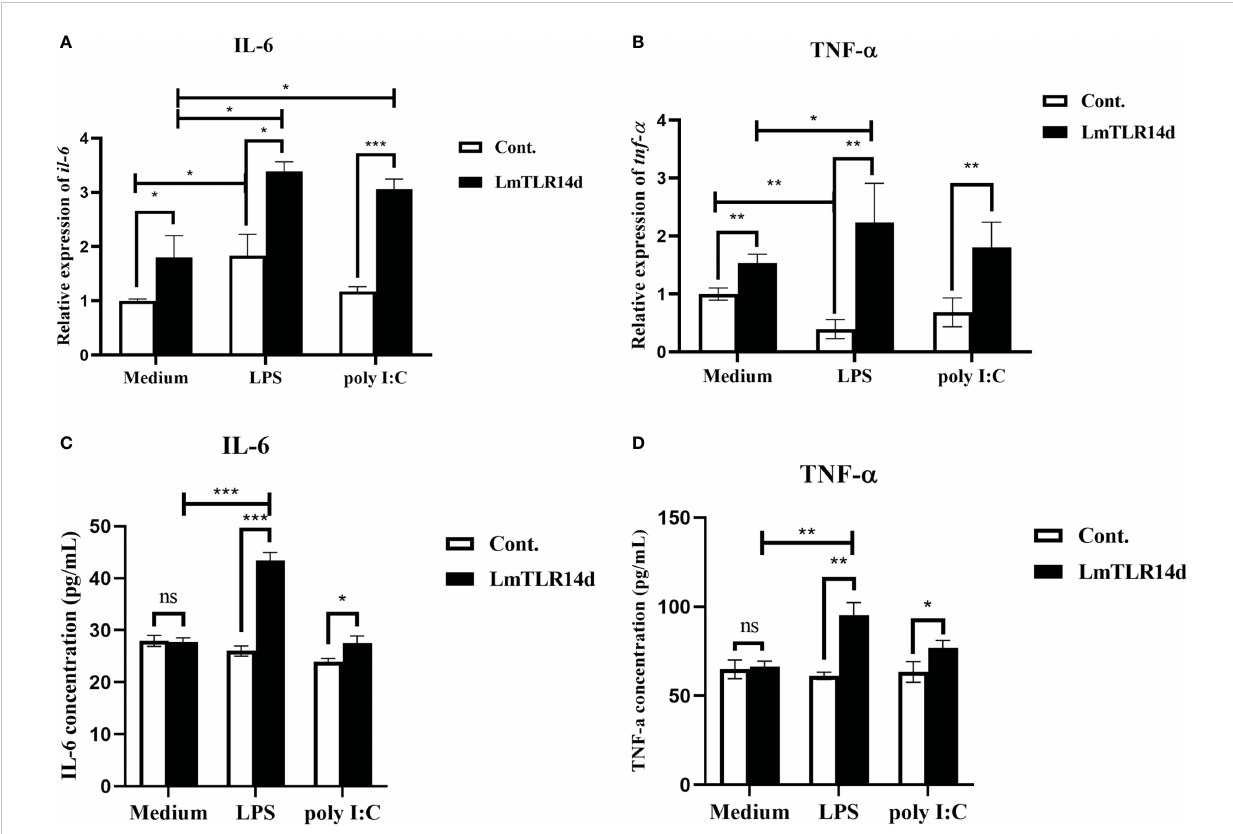
FIGURE 6 Effects of LmTLR14d on in fl ammatory cytokines downstream of NF- k B signal under natural state, LPS stimulation (12 h of incubation) and poly I:C stimulation (12 h of incubation). Quantitative real-time PCR (qPCR) showing effects of LmTLR14d overexpression on il-6 (A) and tnf- a (B) in HEK 293T cells. ELISA showing LmTLR14d regulated the production of in fl ammatory cytokines IL-6 (C) and TNF- a (D) in HEK 293T cells. Bars show mean ± SEM. A one-way ANOVA analysis of variance followed by the Bonferroni multiple comparison test. * means signi fi cant difference (n=3, * P <0.05 ** P <0.01 *** P <0.001). Ns stands for no signi fi cant